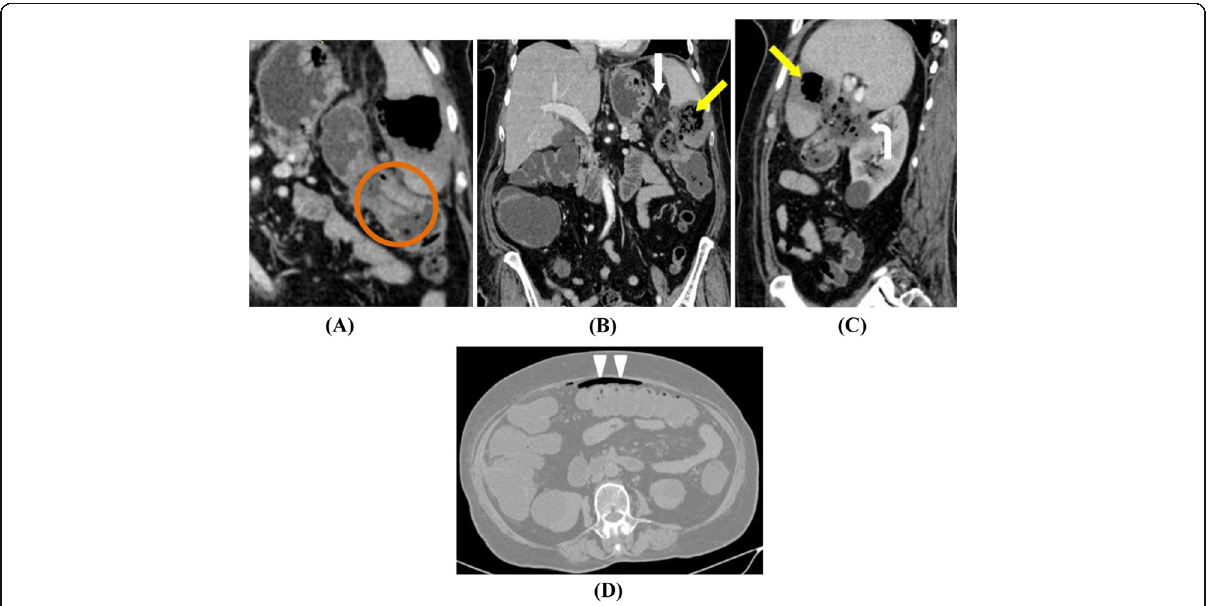
Fig. 14 Perforated colonic carcinoma in a 70-year-old female patient presented with acute left hypochondrial pain and fever. a Focused coronal CT image showing asymmetric circumferential focal mural thickening involving splenic flexure and proximal descending colon with luminal narrowing “ shouldering sign ” (circle). b Coronal CT and c sagittal reformatted CT images showing infiltration of lower part of spleen with localized collection containing gas and fecal matter within the splenic substance, surrounded by hypodense splenic matrix (yellow arrow) with adjacent mild fat stranding (white arrow) and infiltration of the anterior aspect of the left renal parenchyma (curved arrow). d Axial CT (lung window) image showing free pneumoperitoneum (arrowhead), indicating